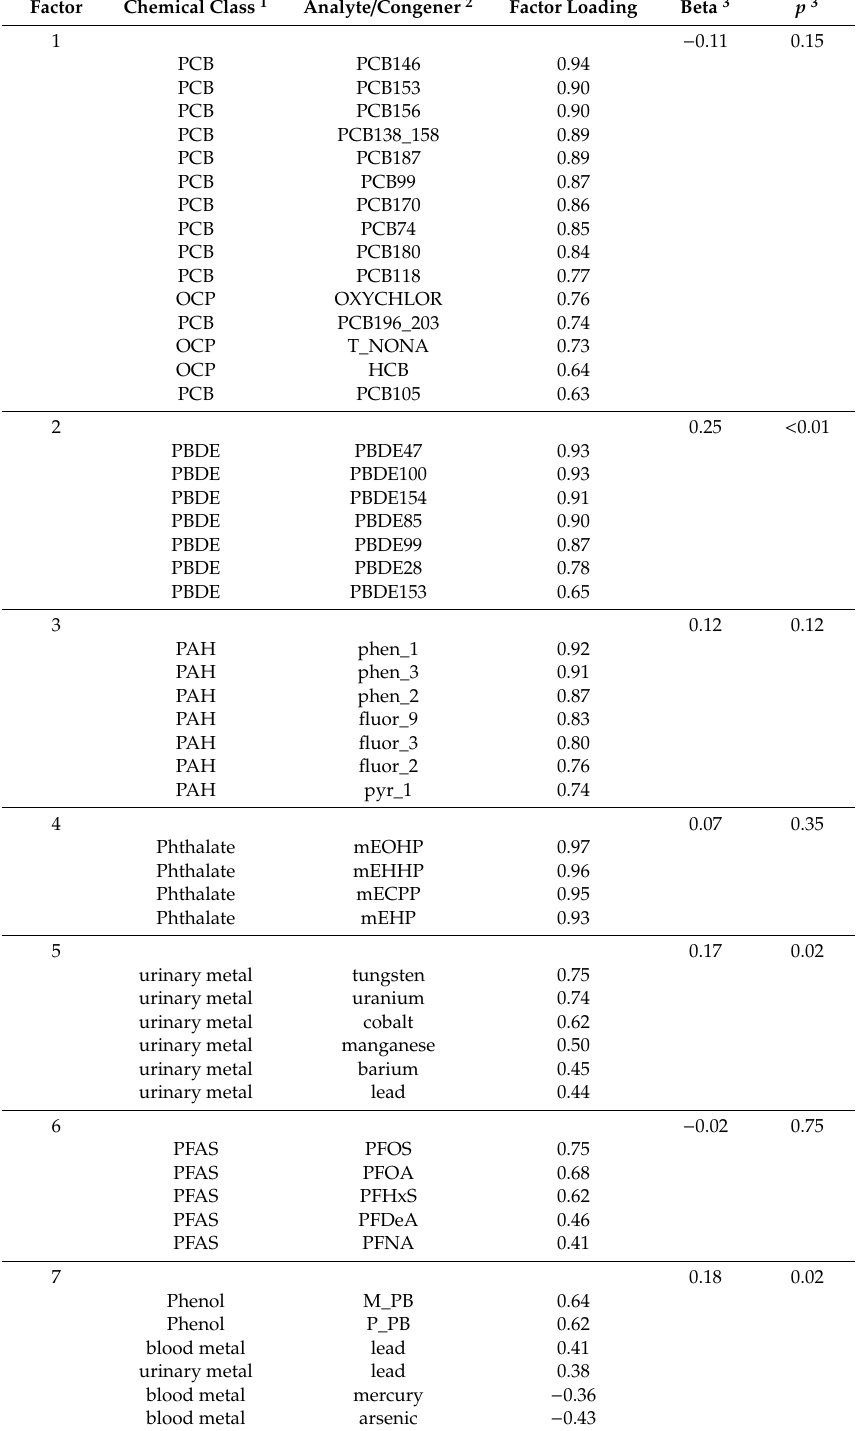
Table 5. Biomarker Co-Exposures and Associations with Urinary Cotinine Using Factor